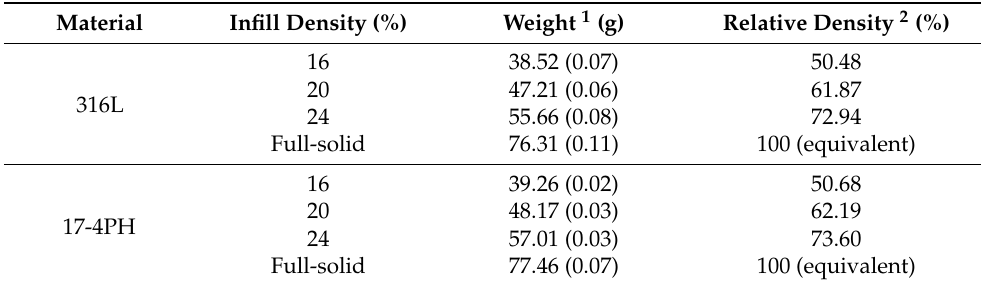
Table 2. The average values of weight and relative density of infill and full-solid specimens.